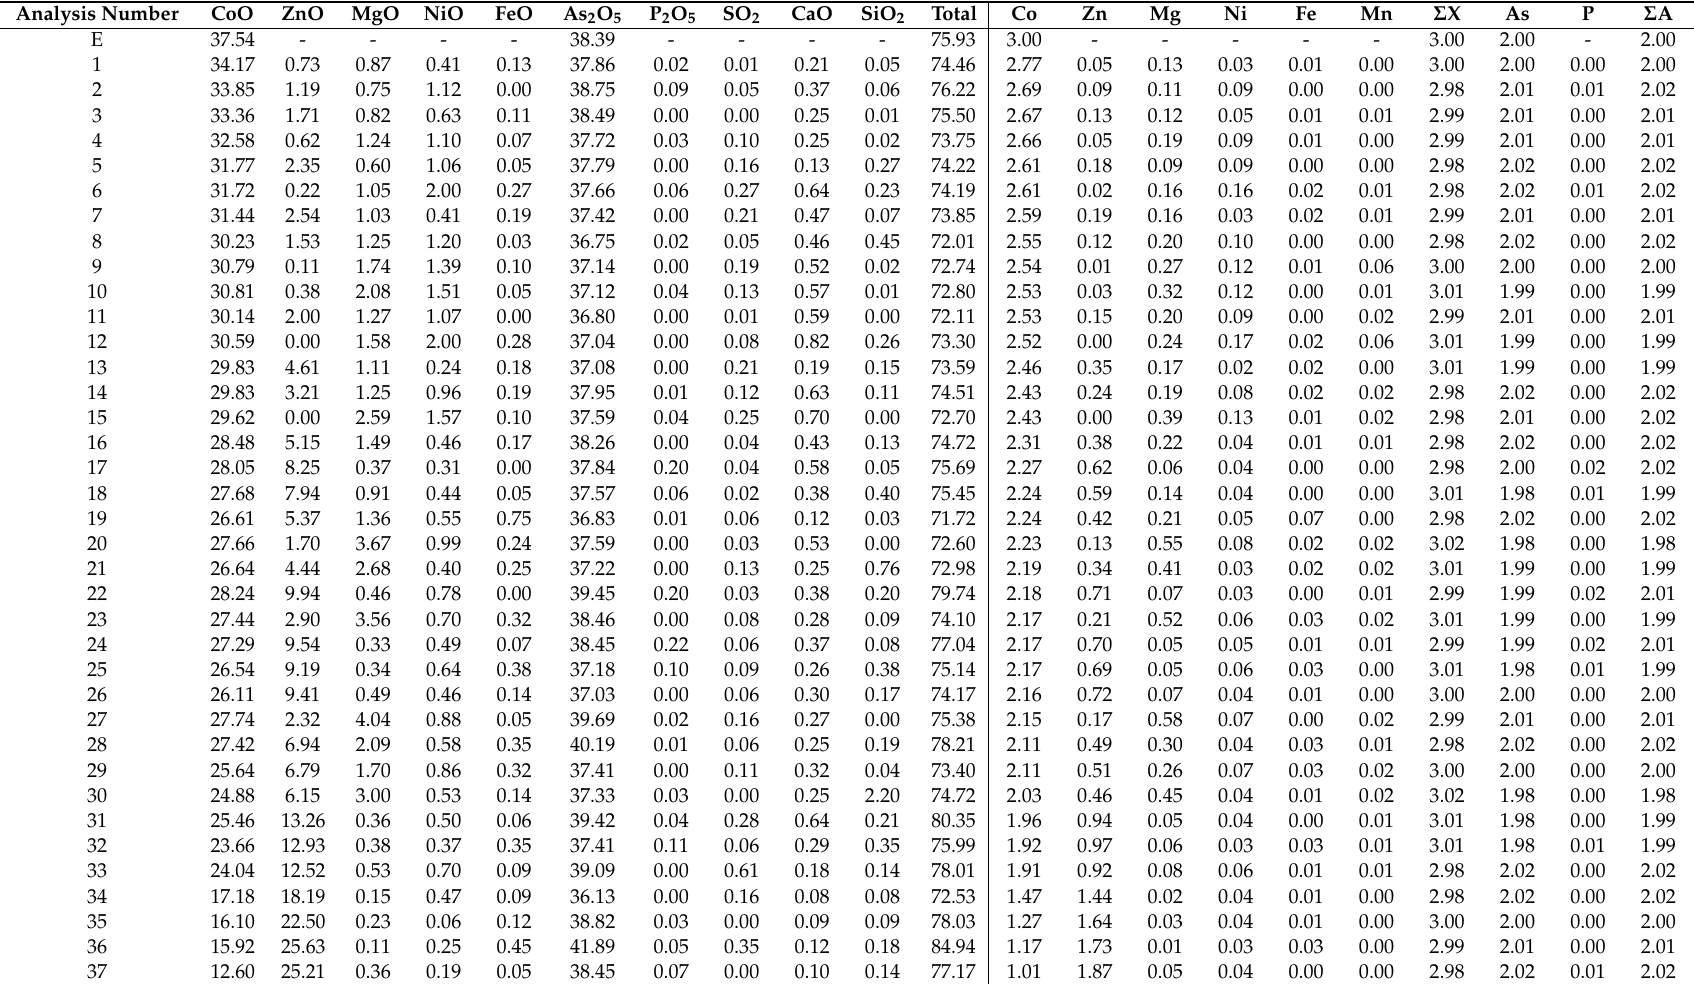
Table 3. Representative EPMA data (wt%) and number of atoms calculated based on five cations in a formula unit of erythrite–köttigite solid solution from Miedzianka, Sudetes Mts; E and K—ideal erythrite and köttigite, respectively. Analysis